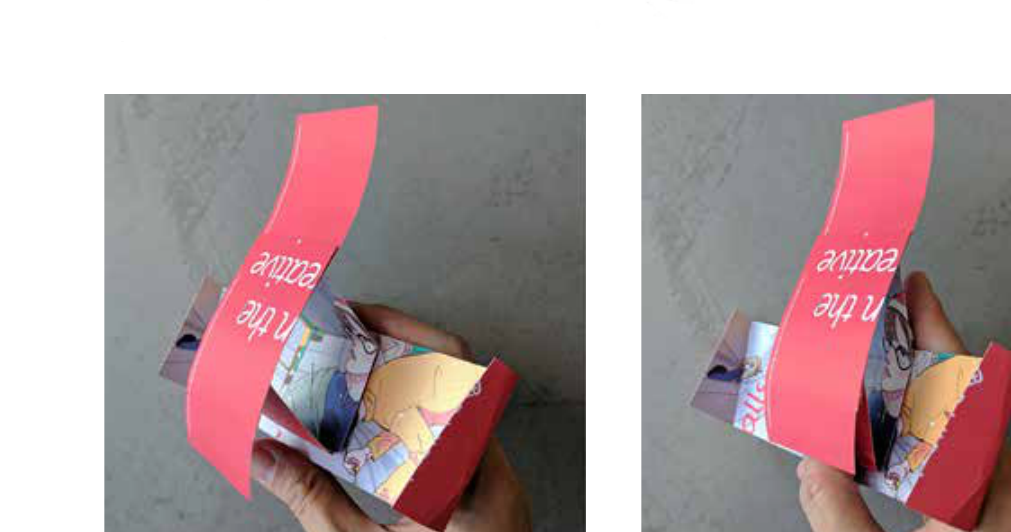
Figure 5 (top): Sketch as a visualisation tool to facilitate visual thinking that enables investigation of, in this case, craftsmanship techniques including the logic of structural form, selection criteria of materials, and fabrication methods. The drawing also facilitates visual driven communication amongst researcher, designer and the producer. Source: author.